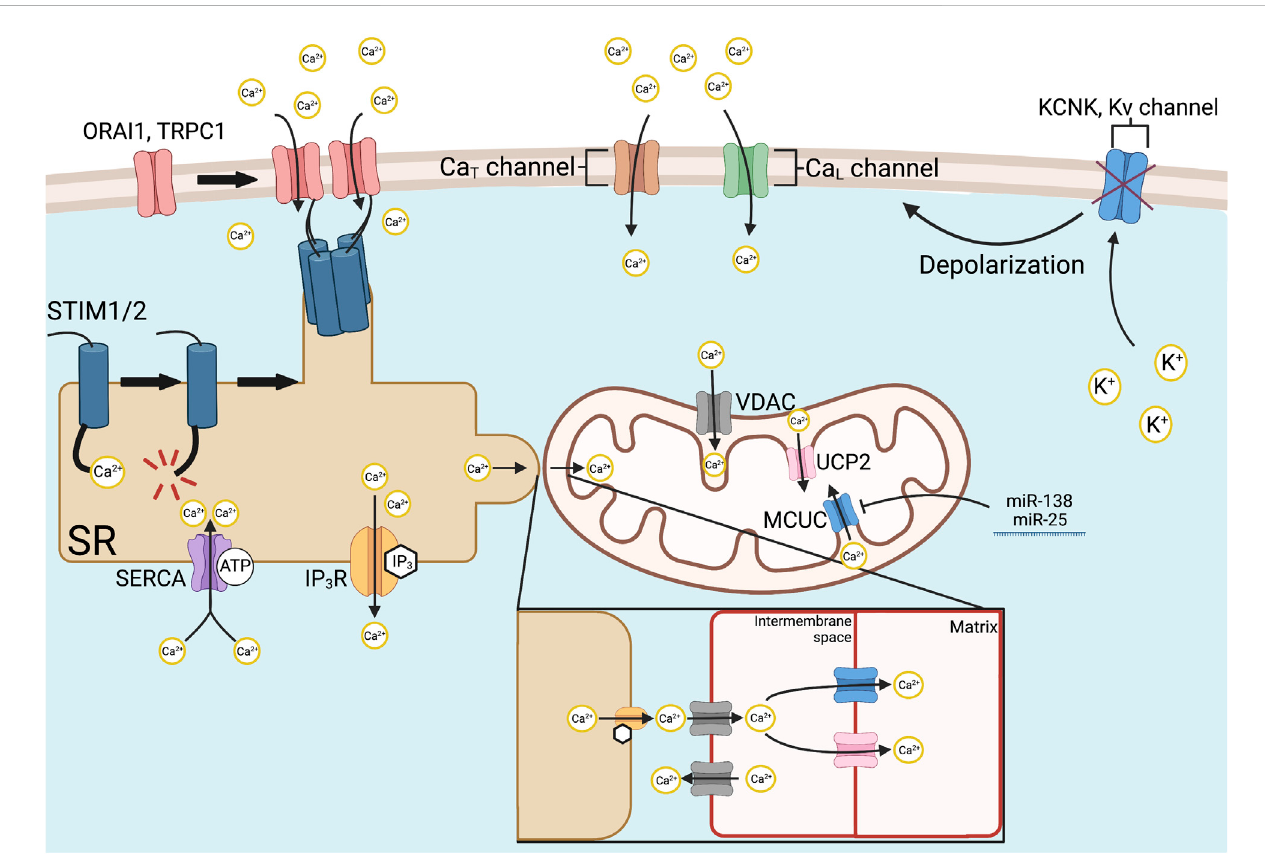
FIGURE 3 Mechanisms of intracellular Ca 2+ regulation. Store-operated Ca 2+ entry is initiated via SR-bound STIM1 and STIM2, which have Ca 2+ -sensitive EF hand domains. Ca 2+ store depletion from the SR causes STIM1/2 to aggregate at SR-plasma membrane junctions and recruits ORAI1, TRPC1, and other Ca 2+ channels by its STIM1 ORAI activating region or CRAC activating domain. Various Ca 2+ channels allow organellar uptake, such as SERCA and release, such as IP 3 Rs, respectively. Mitochondrial Ca 2+ uptake is mediated by the MCUC. The channel-forming subunit of the MCUC, MCU, is epigenetically downregulated in PAH by increased expression of miR-138 and miR-25. MCUC inhibition contributes to the Warburg effect by inactivating Ca 2+ -dependent enzymes that regulate OXPHOS within the mitochondria. In addition, reduced MCUC function increases cytosolic calcium, favoring vasoconstriction. Intramitochondrial calcium is also regulated, under certain conditions by the VDAC on the outer mitochondrial membrane, and UCP2, on the inner mitochondrialmembrane.InPAH,voltage-gatedCa 2+ entryisinitiatedbytheinhibitionanddownregulatedexpressionofredox-sensitiveK + channels,suchas Kv1.5. The loss of tonic K+ ef fl ux depolarizes the PASMC membrane potential, thereby activating L- and T-type Ca 2+ channels and allowing in fl ux of extracellular calcium down its 20,000/1 extracellular to intracellular concentration gradient. Abbreviations: Ca L/T — L/T-type calcium channel; IP 3 R — Inositol- 1,4,5-triphosphate receptor; KCNK4 — Potassium channel subfamily K member four; Kv — Voltage-gated potassium channel; MCUC — Mitochondrial